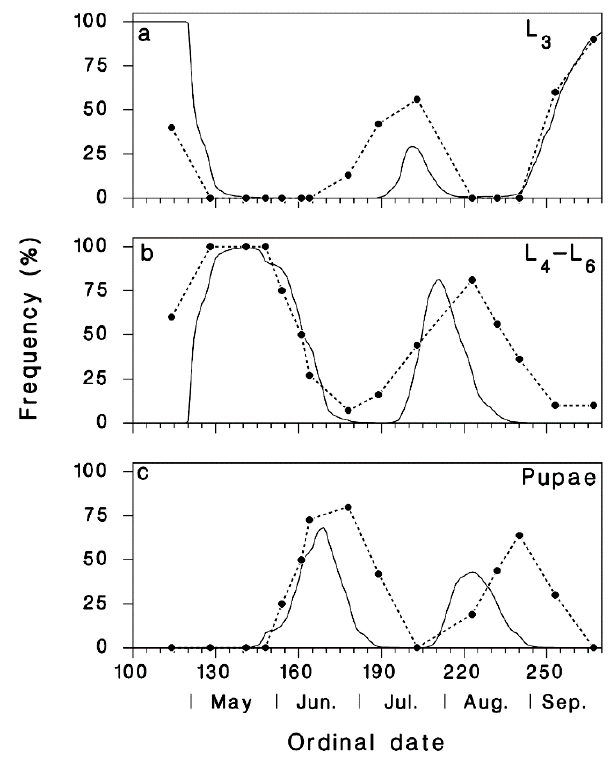
Figure 4. Comparison of observed ( ● ) and simulated ( ‒‒‒ ) frequency of various immature life stages of the OBL in the Willamette Valley, Oregon, in 1976 (data from Table 1 in [38]).